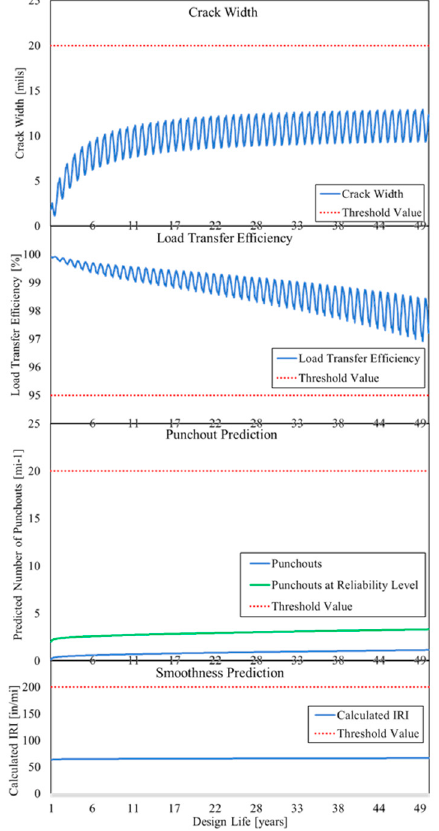
Figure 9. Variation of: CW, LTE, punchout prediction, and smoothness prediction over time from MEPDG on Geseke.